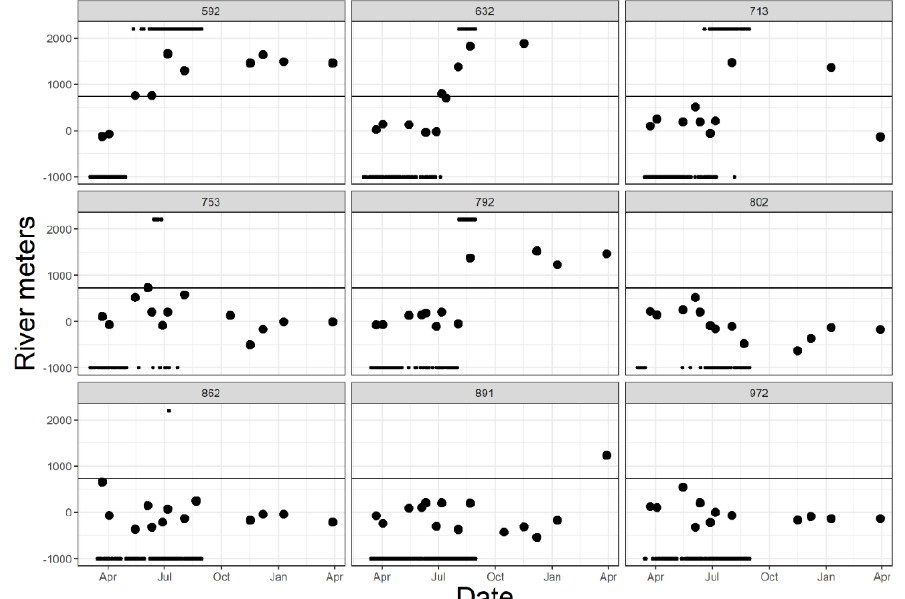
Figure 4. Fish detected over the study period (March 2012–March 2013). River meters from the release site on the Y -axis and time on the X -axis. Large dots represent manually tracked positions, whereas the smaller dots at the top and bottom of each plot represent detections in the vicinity of the upstream and downstream receivers (unrelated to the river meter axis). The black line constitutes the longitudinal position of the Dora Baltea River confluence. Fish IDs as plot subtitles.